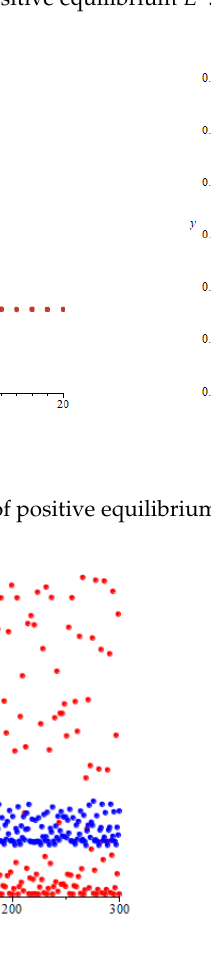
Figure 2. Local stability of positive equilibrium E ∗ .